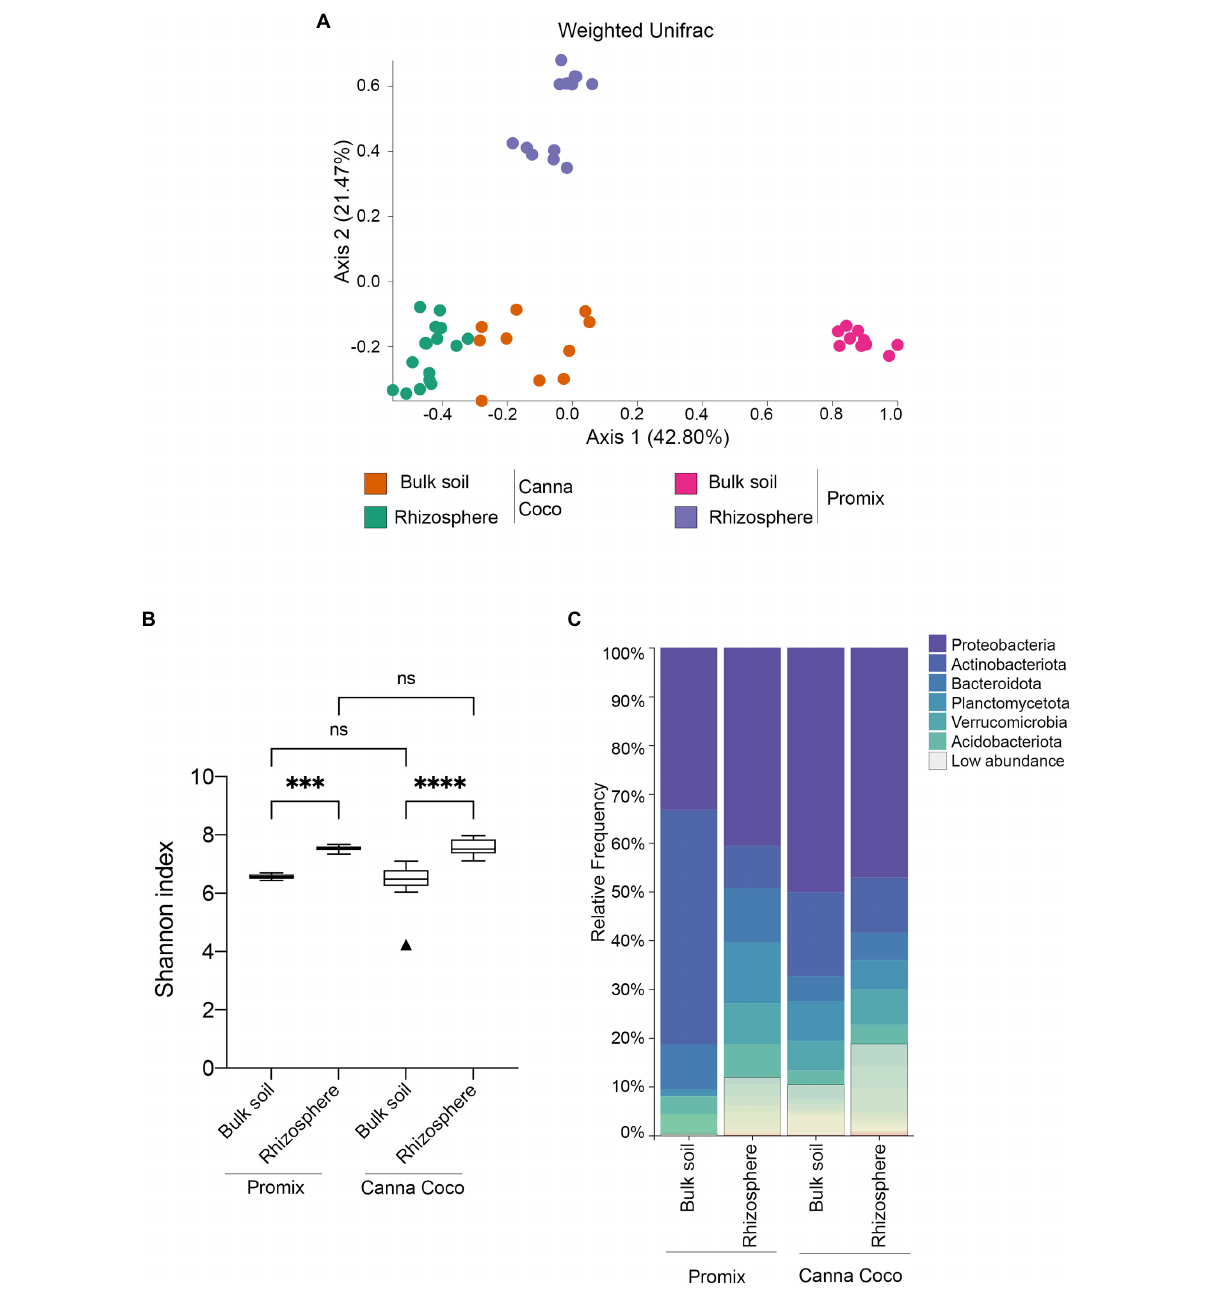
FIGURE 2 | Diversity metrics and taxonomical differences, between untreated substrates, in the bacterial microbiome of C. sativa ’s rhizosphere and bulk soil. (A) Weighted UniFrac PCoA plot representative of substrate differences in the bulk soil and rhizosphere. Each point represents a sample and axis 1 and axis 2 represent the percentage of variance explained by each coordinate. (B) Shannon’s index of variations between the bulk soil and rhizosphere of Promix and Canna coco. Kruskal–Wallis pair-wise test was used to assess statistical significance between groups ( * p < 0.05, ** p < 0.01, *** p < 0.001, **** p < 0.0001). (C) Taxonomic bar plots of the relative frequency of bacteria at the phylum level between soil location and substrate. Low abundance taxa included: Chloroflexi, Myxococcota, Cyanobacteria, Bdellovibrionota, Gemmatimonadota, Armatimonadota, Firmicutes, Patescibacteria, Delsufobacterota, Hydrogenedentes,